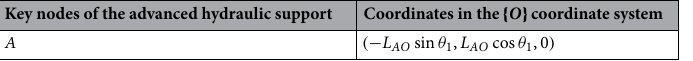
Table 4. Coordinates of A in the { O } coordinate system.